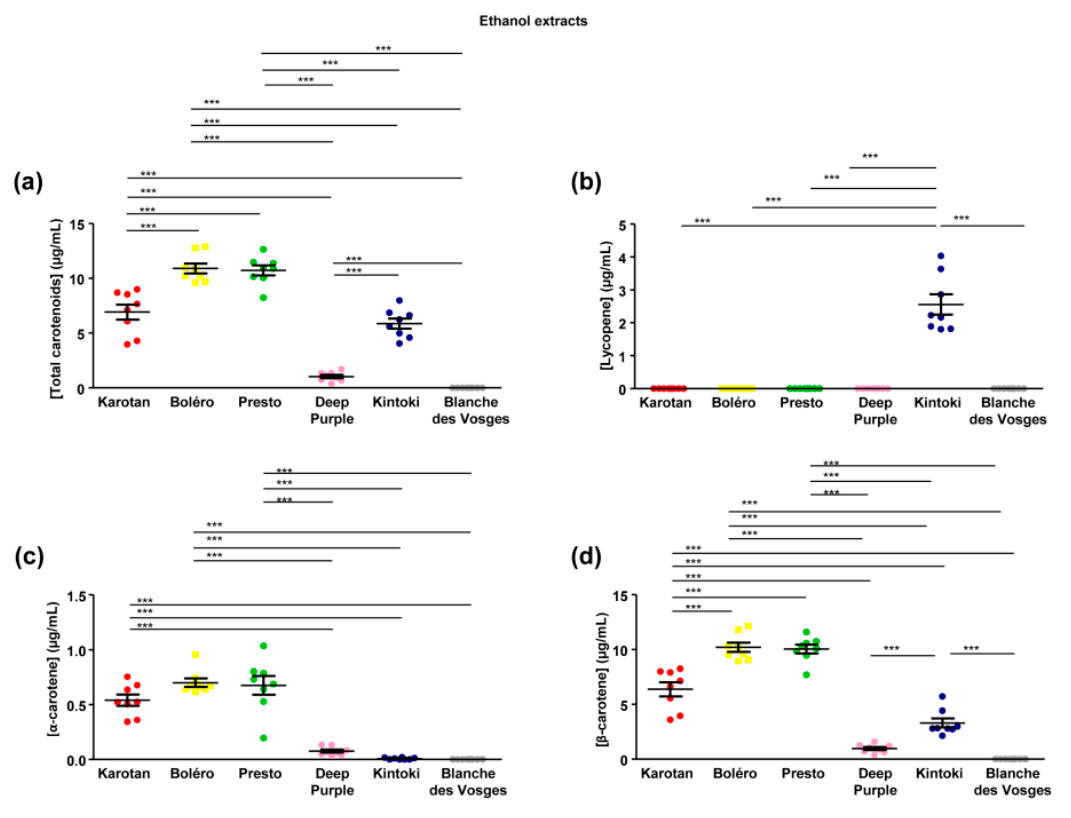
Figure 2. Carotenoid content in carrot’s ethanol extracts. Diagrams represent content of ( a ) total carotenoids, ( b ) lycopene, ( c ), α -carotene, ( d ) β -carotene in ethanol extracts from six di ff erent